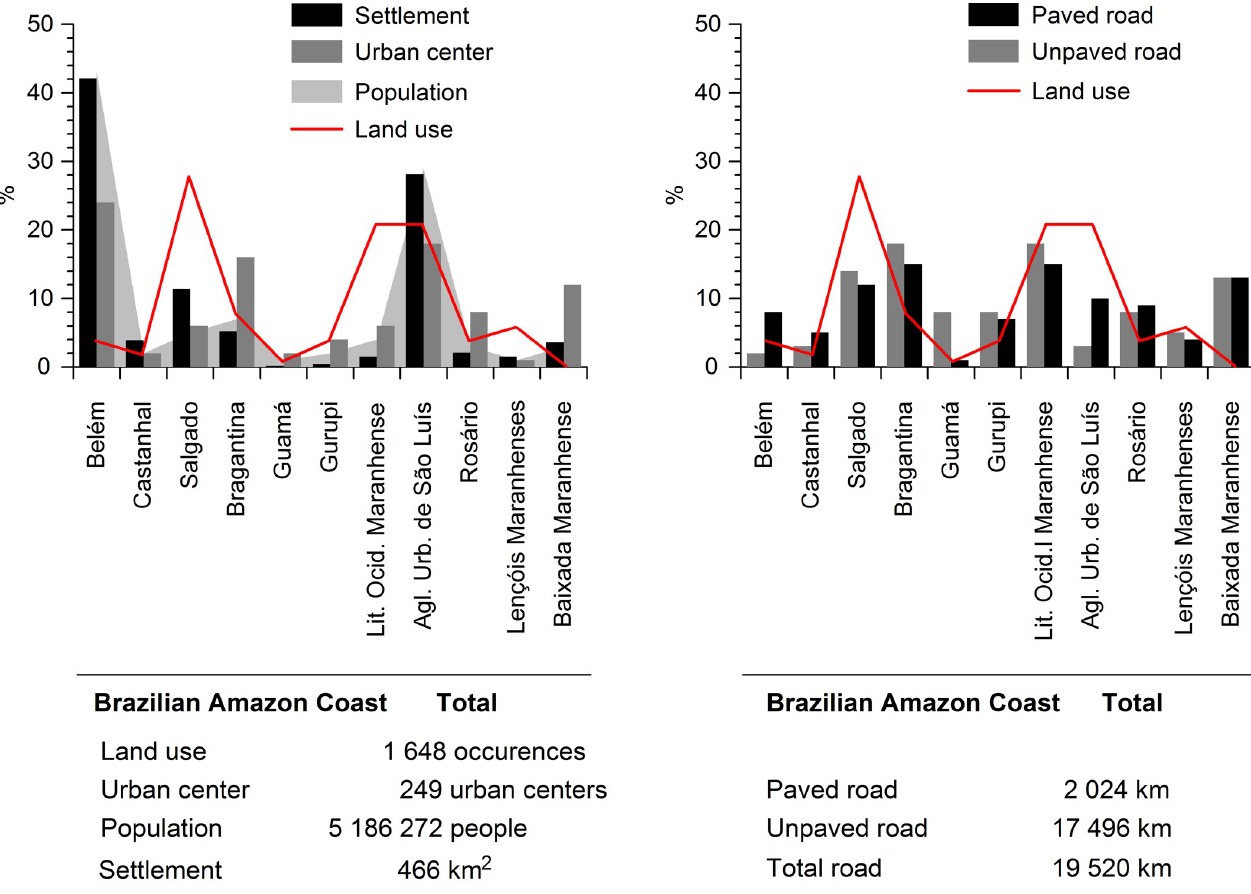
Fig 4. Distribution of mangrove land use and anthropogenic drivers in the different microregions of the Brazilian Amazon coast. The microregions on the x-axis are arranged in latitudinal order, i.e. from west to east (see Fig 1).